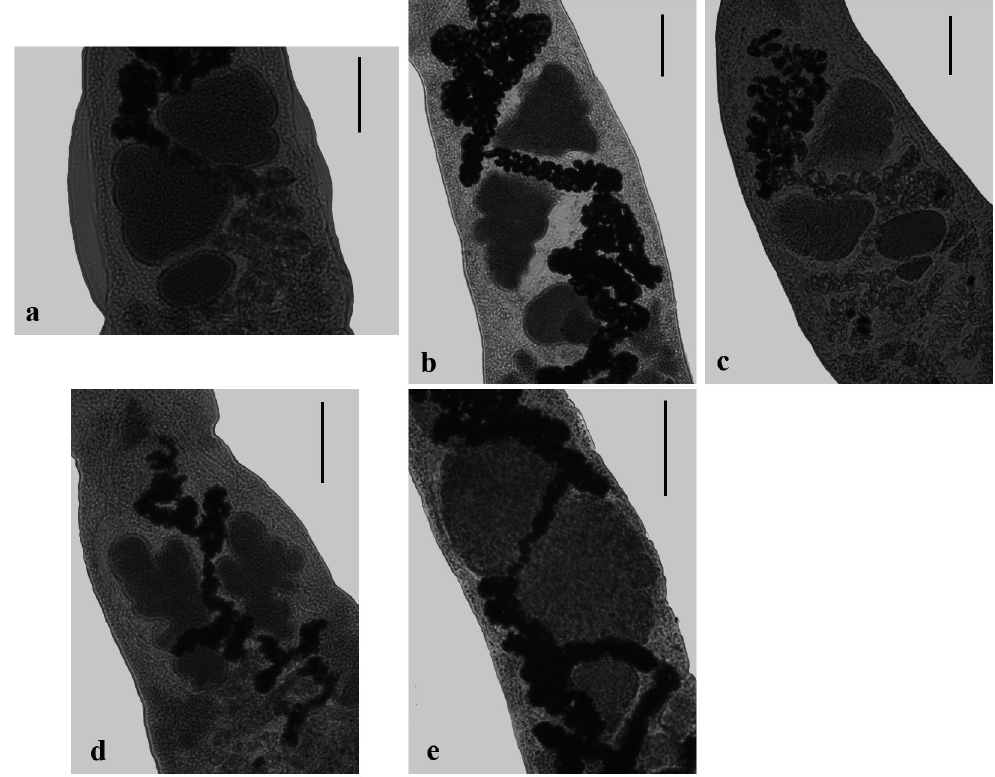
Figure 2 - Forms of the testis: a ) lobed [ Puebla, CNHE 3872 ] , b ) triangular [ Zacatecas, CNHE 3870 ] , c ) reniform [ Nuevo León, CNHE 3871 ] , d ) rosette [ Nuevo León, CNHE 3871 ] , e ) oval [ Durango, CNHE 3875 ]